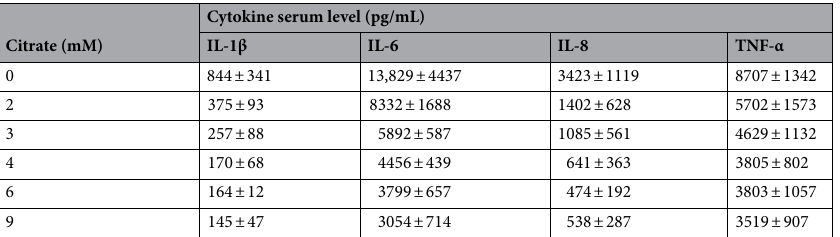
Table 1. Cytokine levels of LPS spiked whole blood as a function of citrate level. Fresh blood from three different donors was spiked with different amounts of citrate. After addition of 10 ng/mL LPS and 4 h incubation at 37 °C, the cytokine serum levels were